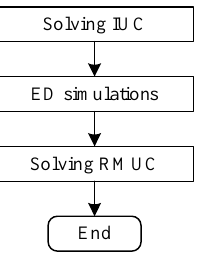
Figure 7. Methodology of solving RMUC.